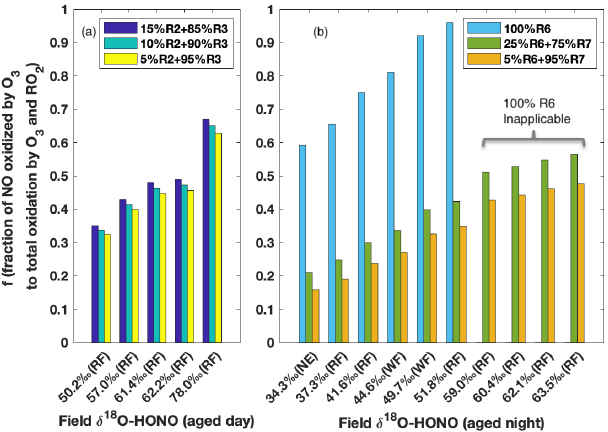
Figure 6. Model prediction of fraction of NO oxidized to NO 2 via O 3 to that via O 3 and RO 2 together ( f NO ) on the O 3 /( O 3 + RO 2 ) basis of field-measured δ 18 O-HONO for aged daytime (a) and nighttime (b) smoke. During the day (a) , the contribution of Re- action (R2) to HONO production is varied from 5% to 15% fol- lowing M1 in Fig. 5, and Reaction (R3) accounts for the remaining secondary HONO contribution. The modeling results are shown in Fig. S5 and Table S3 in the Supplement. During the night (b) , three scenarios with various contributions of Reactions (R6) and (R7) are modeled (Fig. S6 and Table S4). f NO is predicted to be O 3 /( O 3 + RO 2 ) over unity for the last four observed δ 18 O-HONO values if Reac- tion (R6) is assumed as the only nighttime